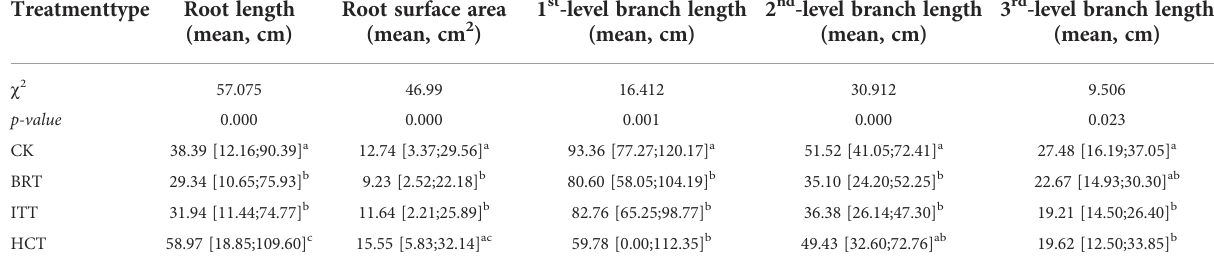
TABLE 1 Comparable traits of root systems and three-level branches among the treatments.